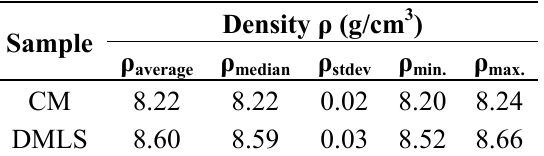
Table 6. Results of density analysis.